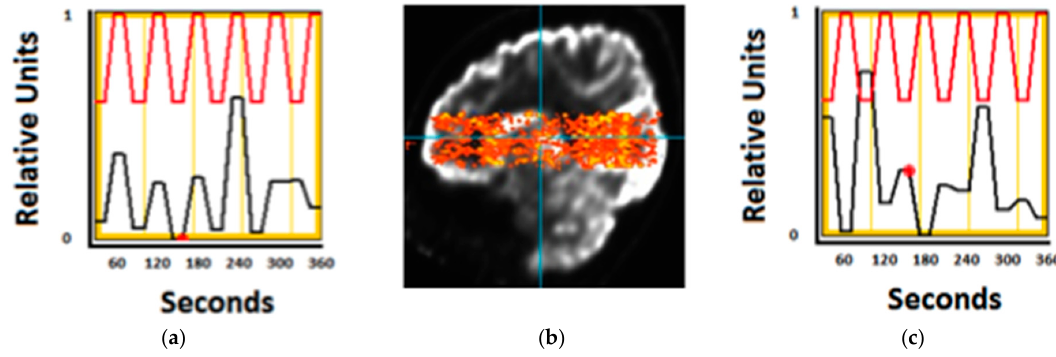
Figure 7. ( b ) Image from Generation 0 imager (activity in warm colors) is overlaid onto that of standard PET anatomical slice (greyscale) to show the plane of image acquisition on the head. This is a sagittal slice from front (left) to back (right) of brain, with the top of the brain at the top of the picture and cerebellum/brain stem at the bottom. Individual voxels were analyzed to see if they either increased in activity during the hand task (correlated, ( a )) vs. foot tapping task (anti-correlated, ( c )). Red represents an ideal model waveform, while the black represents actual intensity differences in the image due to higher count rates (averaged to one measure during each 30 s period for this analysis).